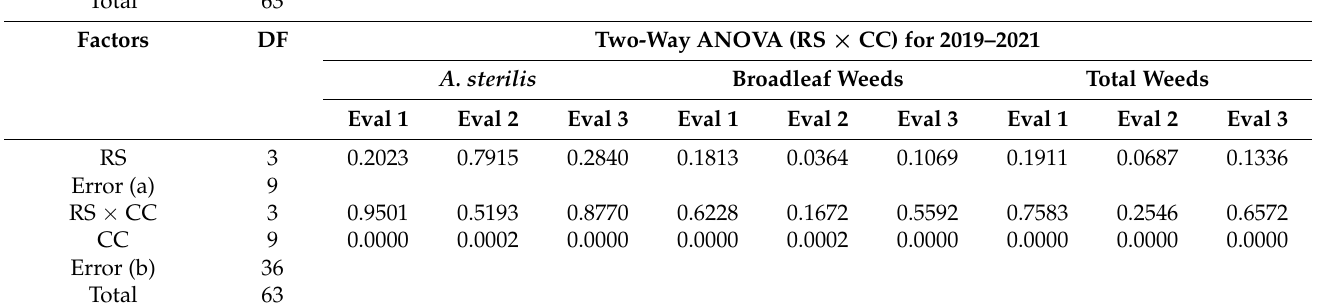
Figure 2. ( a ) Biomass of A. sterilis (g m − 2 ). ( b ) Biomass of broadleaved weeds (g m − 2 ). ( c ) Total weed biomass (g m − 2 ). Data are for the first year of sulla growth in the 2018–2020 and 2019–2021 growing cycles. Different lowercase letters indicate significant differences. Vertical bars indicate standard errors.